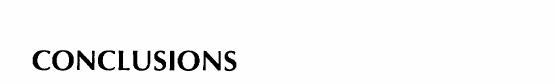
FIGURE 14 Decibel amplitude of second order (FFT based).